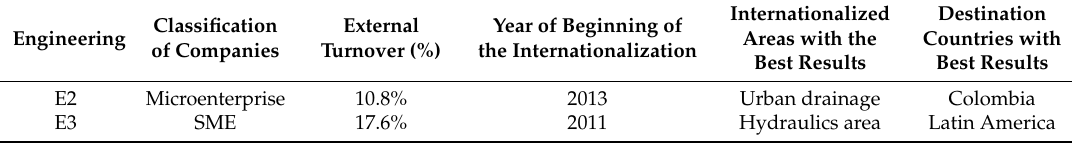
Table 10. Characteristics of the companies that give the lowest score to risk